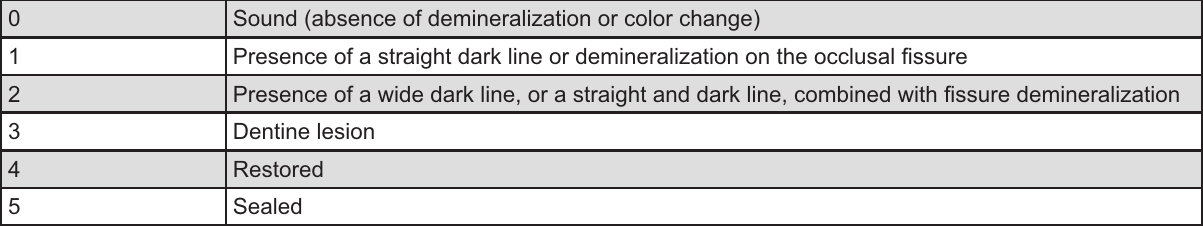
Figure 1- Weerheijm, Gruythuysen and Van Amerongen 19 (1992) criteria for clinical